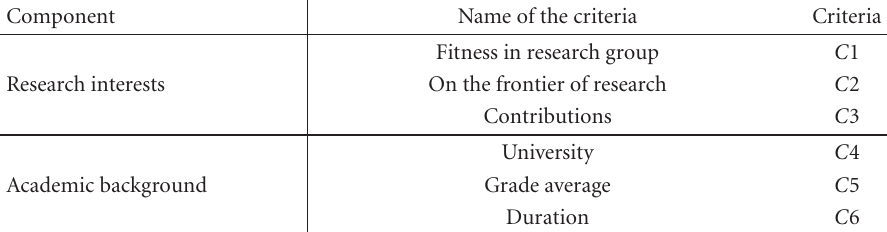
Table 4.1. Collection of